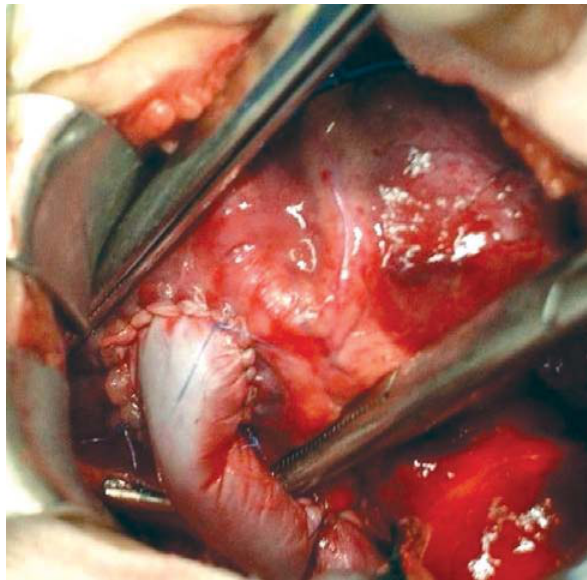
Fig. 1- Conduto extracardíaco - Completado enxerto biológico entre ventrículo direito e tronco de artéria pulmonar por sobre a artéria coronária